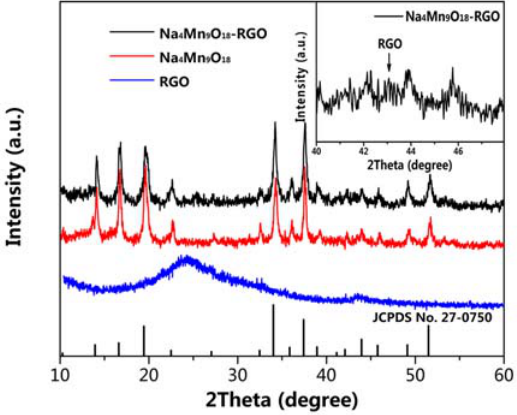
Figure 2. XRD patterns of Na 4 Mn 9 O 18 , Na 4 Mn 9 O 18 ‐ RGO, and RGO.